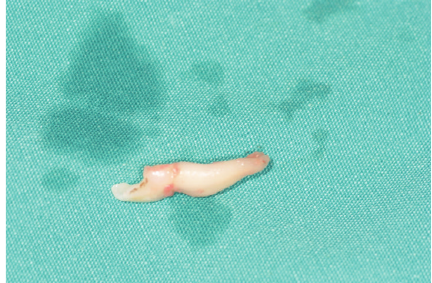
Figure 7: Mesial part of the fused teeth.